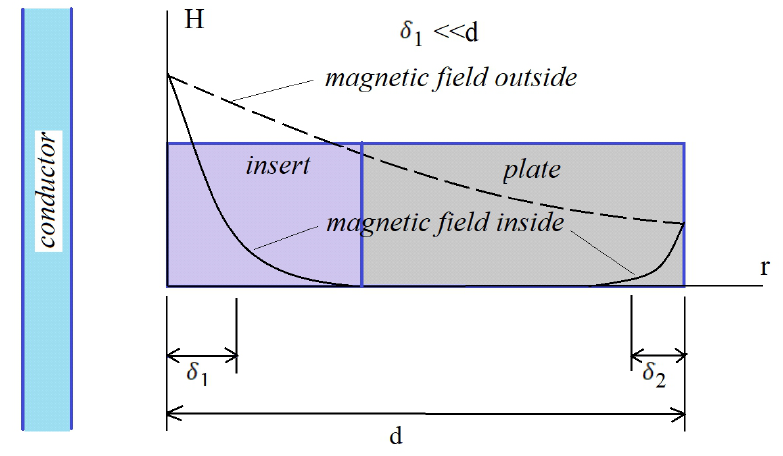
Figure 7. Magnetic field behaviour in the insert and the neighbouring plate material.